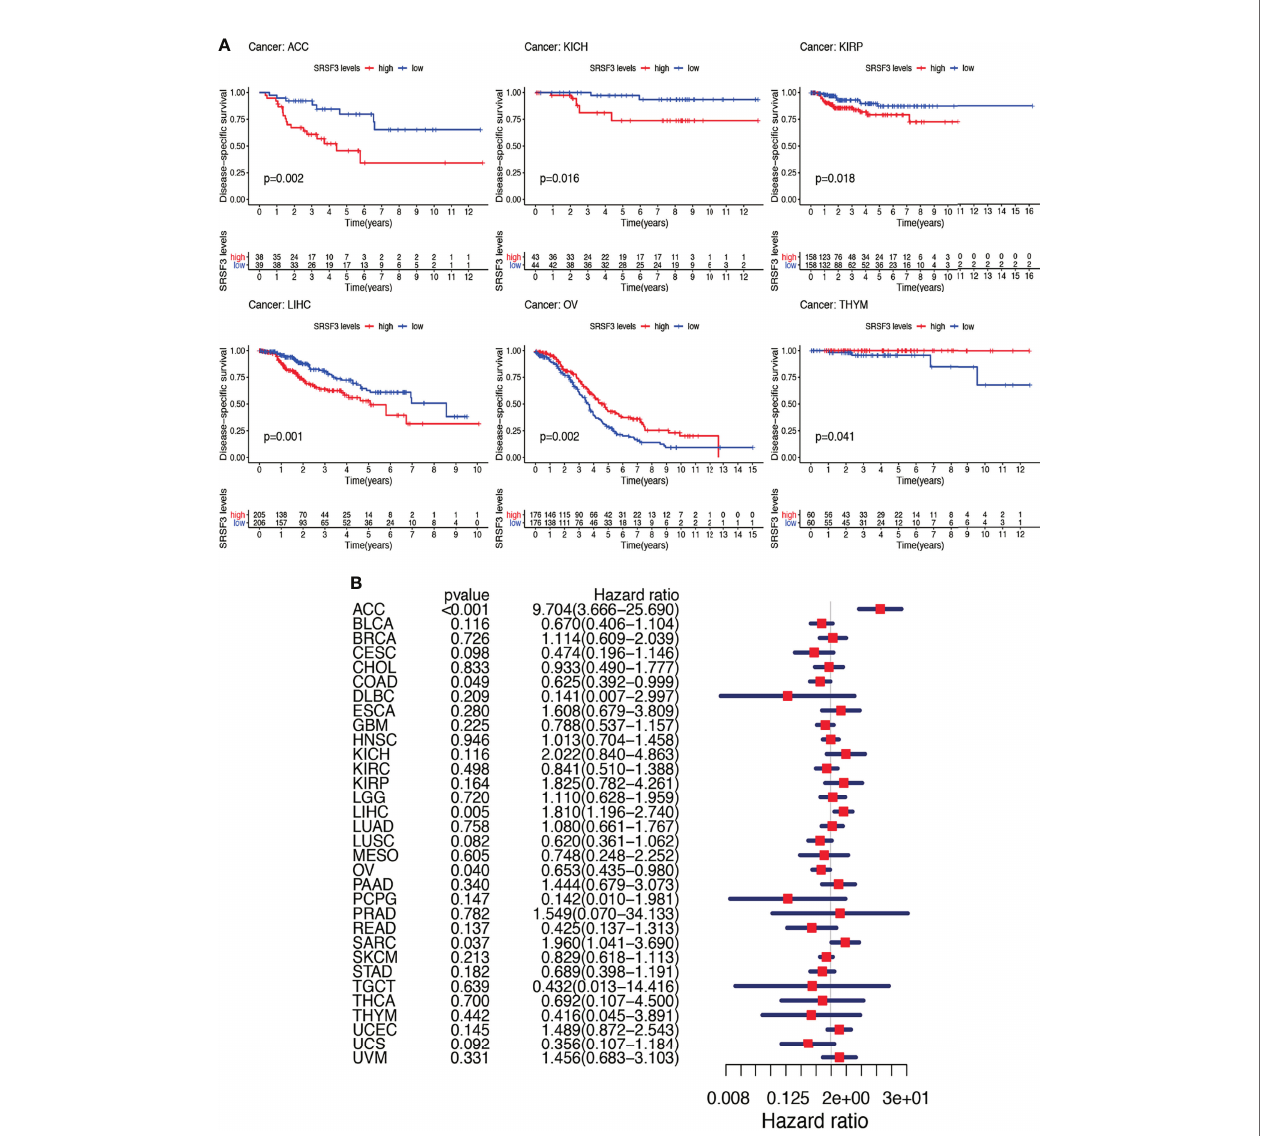
FIGURE 4 | Between DSS and the expression of SRSF3 among human pan-cancer. (A) Association between expression levels of SRSF3 and DSS in different tumors from TCGA database. P < 0.05 is considered to be statistically signi fi cant. (B) DSS difference between high and low SRSF3 expression groups (divided by median expression values) in signi fi cant prognosis-related tumors from TCGA database. DSS difference between groups in ACC. DSS difference between groups in KICH. DSS difference between groups in KIRP. DSS difference between groups in LIHC. DSS difference between groups in OV. DSS difference between groups in THYM. P < 0.05 is considered to be statistically signi fi cant and dash lines represents 95% con fi dence